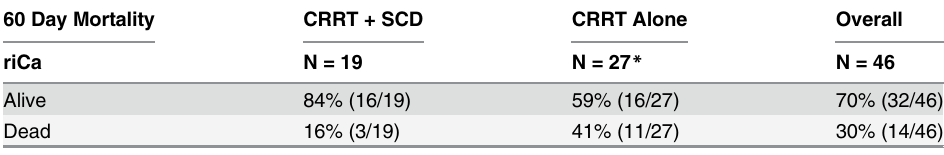
Table 6. 60 Day Mortality of Subjects – Recommended Ionized Calcium Range